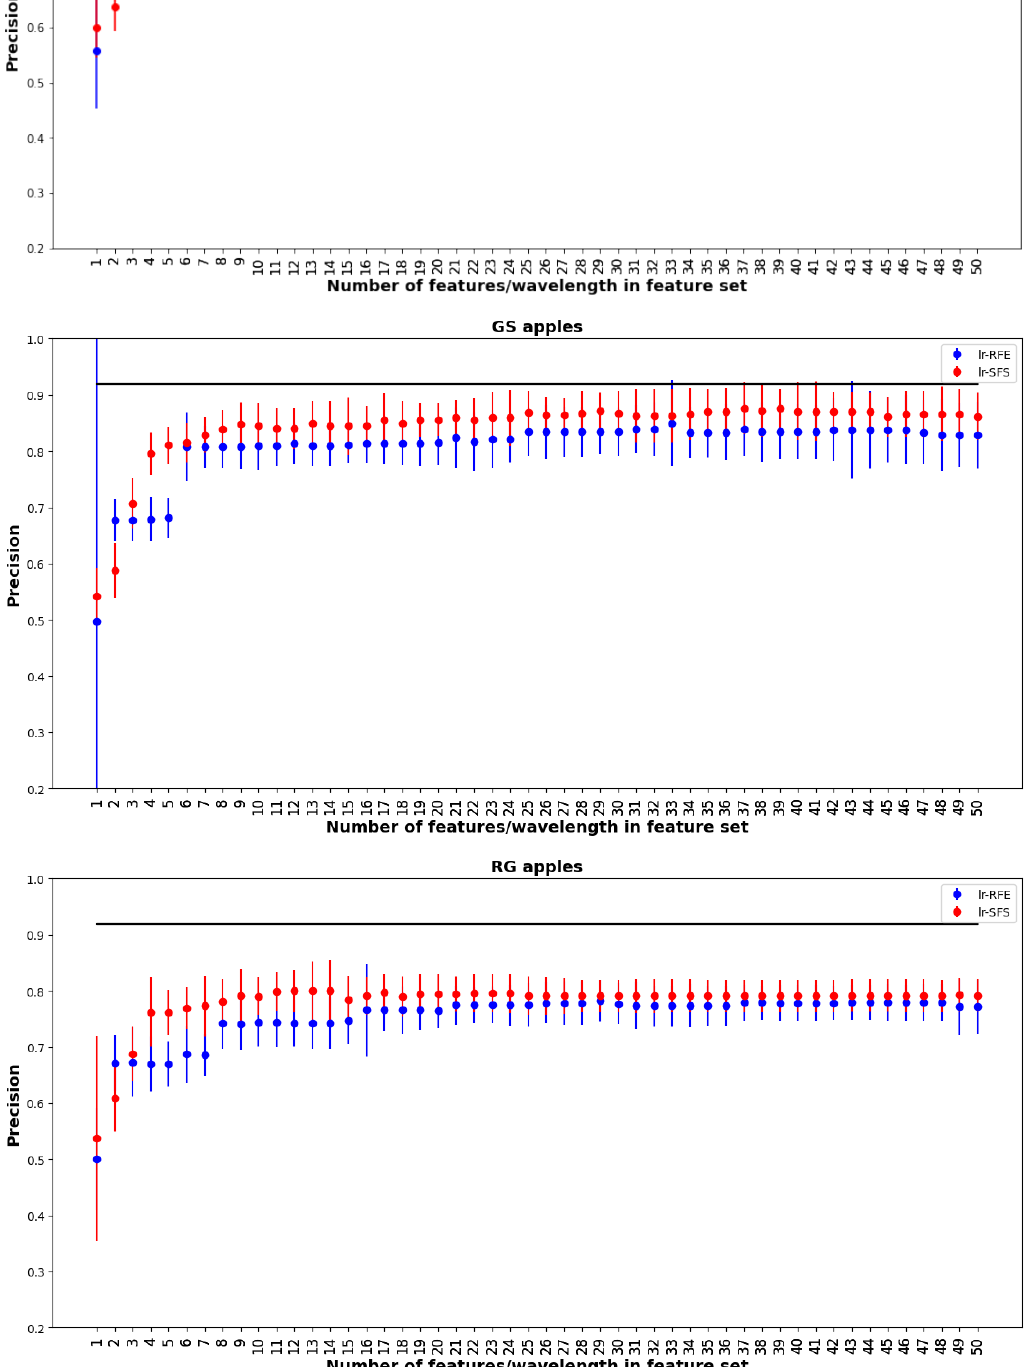
Figure 4. Best 50 feature sets using RFE and SFS on the 3 data sets using